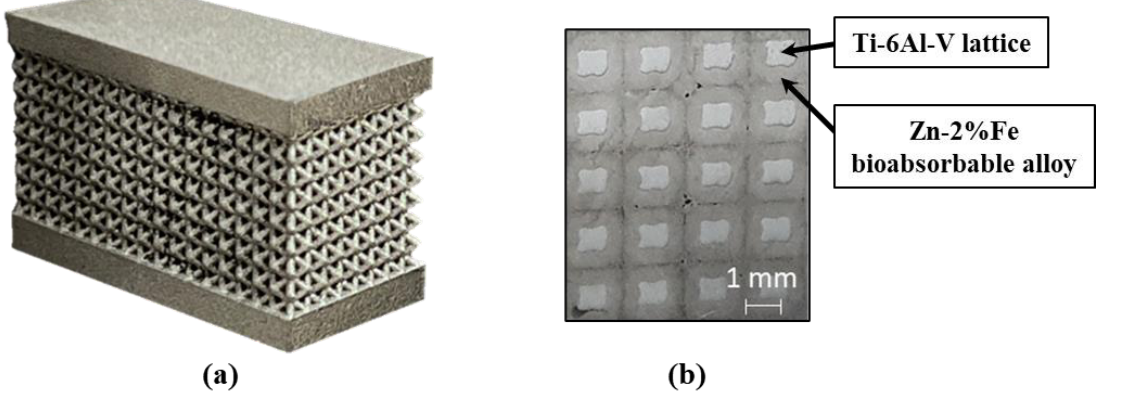
Figure 1. General appearance of ( a ) Ti-6Al-4V lattice pre-infiltration; ( b ) close-up view of Ti-6Al-4V lattice post-infiltration.